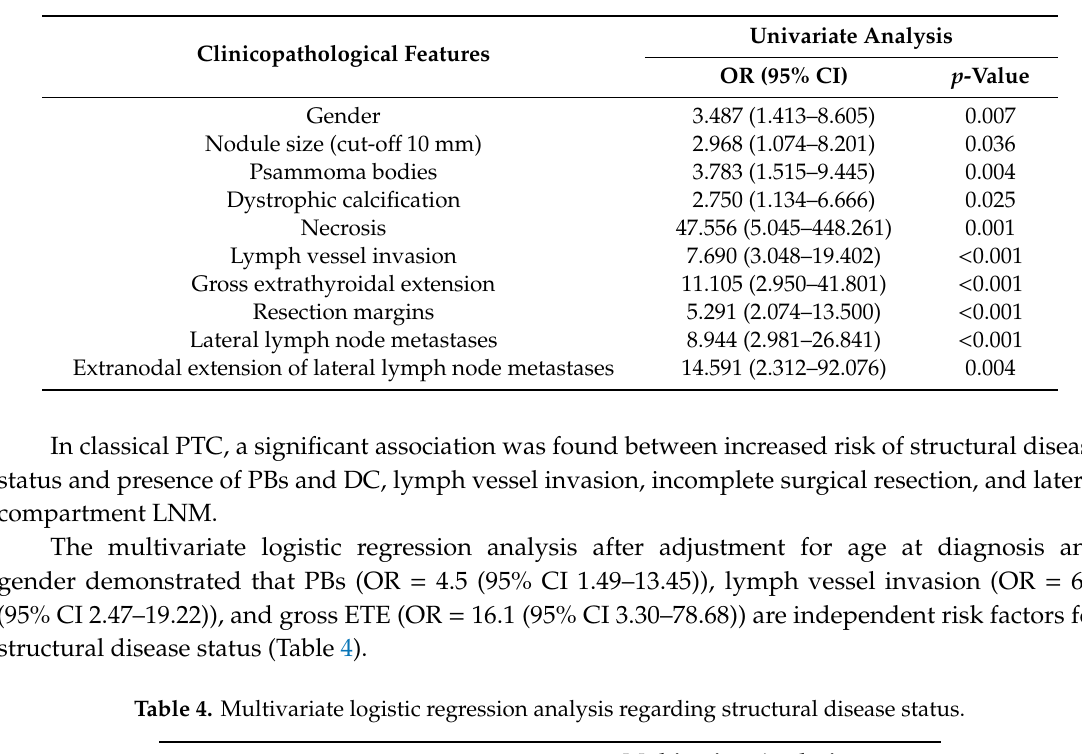
Table 3. Univariate analysis regarding structural disease status.